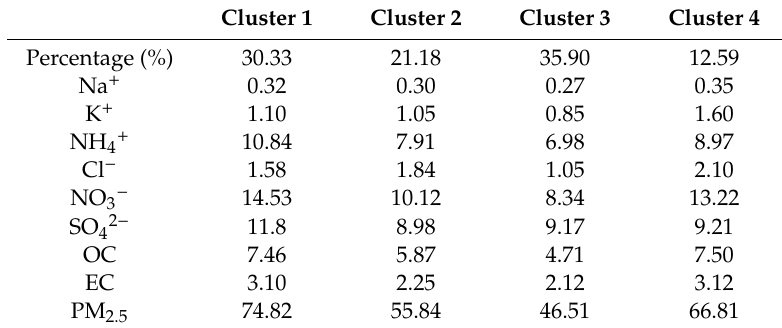
Table 2. Percentages and mean concentrations of PM 2.5 and its major chemical compositions ( µ g · m − 3 ) from each trajectory cluster.